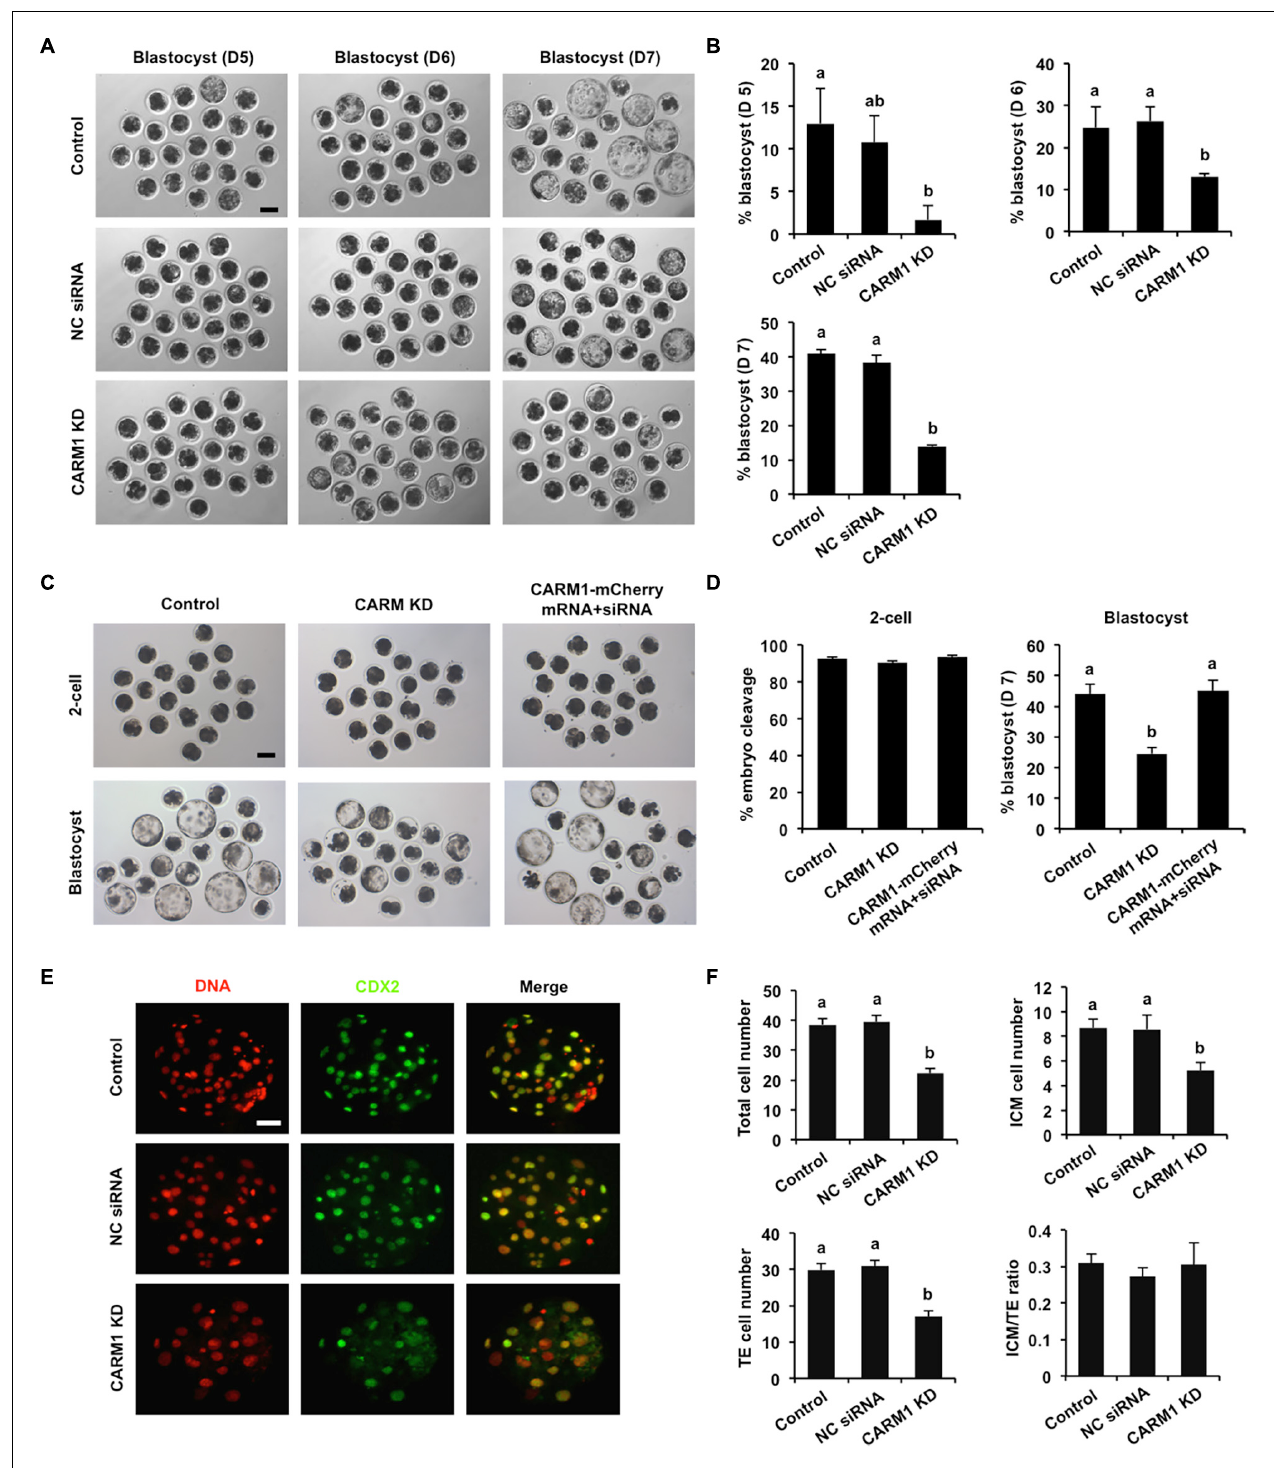
FIGURE 4 | Effect of CARM1 knockdown on blastocyst development and lineage allocation. (A) Representative images of blastocysts from different stages at days 5, 6, and 7. Scale bar: 100 µ m. (B) Analysis of blastocyst rates at days 5, 6, and 7. (C) Representative images of 2-cell embryos and blastocysts. Scale bar: 100 µ m. (D) Analysis of cleavage and blastocyst rates. (E) Representative fluorescence images of blastocysts. Embryos at different groups were stained for CDX2 (green) and DNA (red). The experiment was independently repeated three times with at least 20 blastocysts per group. Scale bar: 50 µ m. (F) Analysis of lineage allocation in blastocysts. The numbers of total cells, ICM cells, TE cells, and the ratio of ICM cells to TE cells were recorded and subject to statistical analysis. ICM: inner cell mass; TE: trophectoderm. All data are shown as mean ± S.E.M and different letters on the bars indicate significant differences ( P < 0.05).